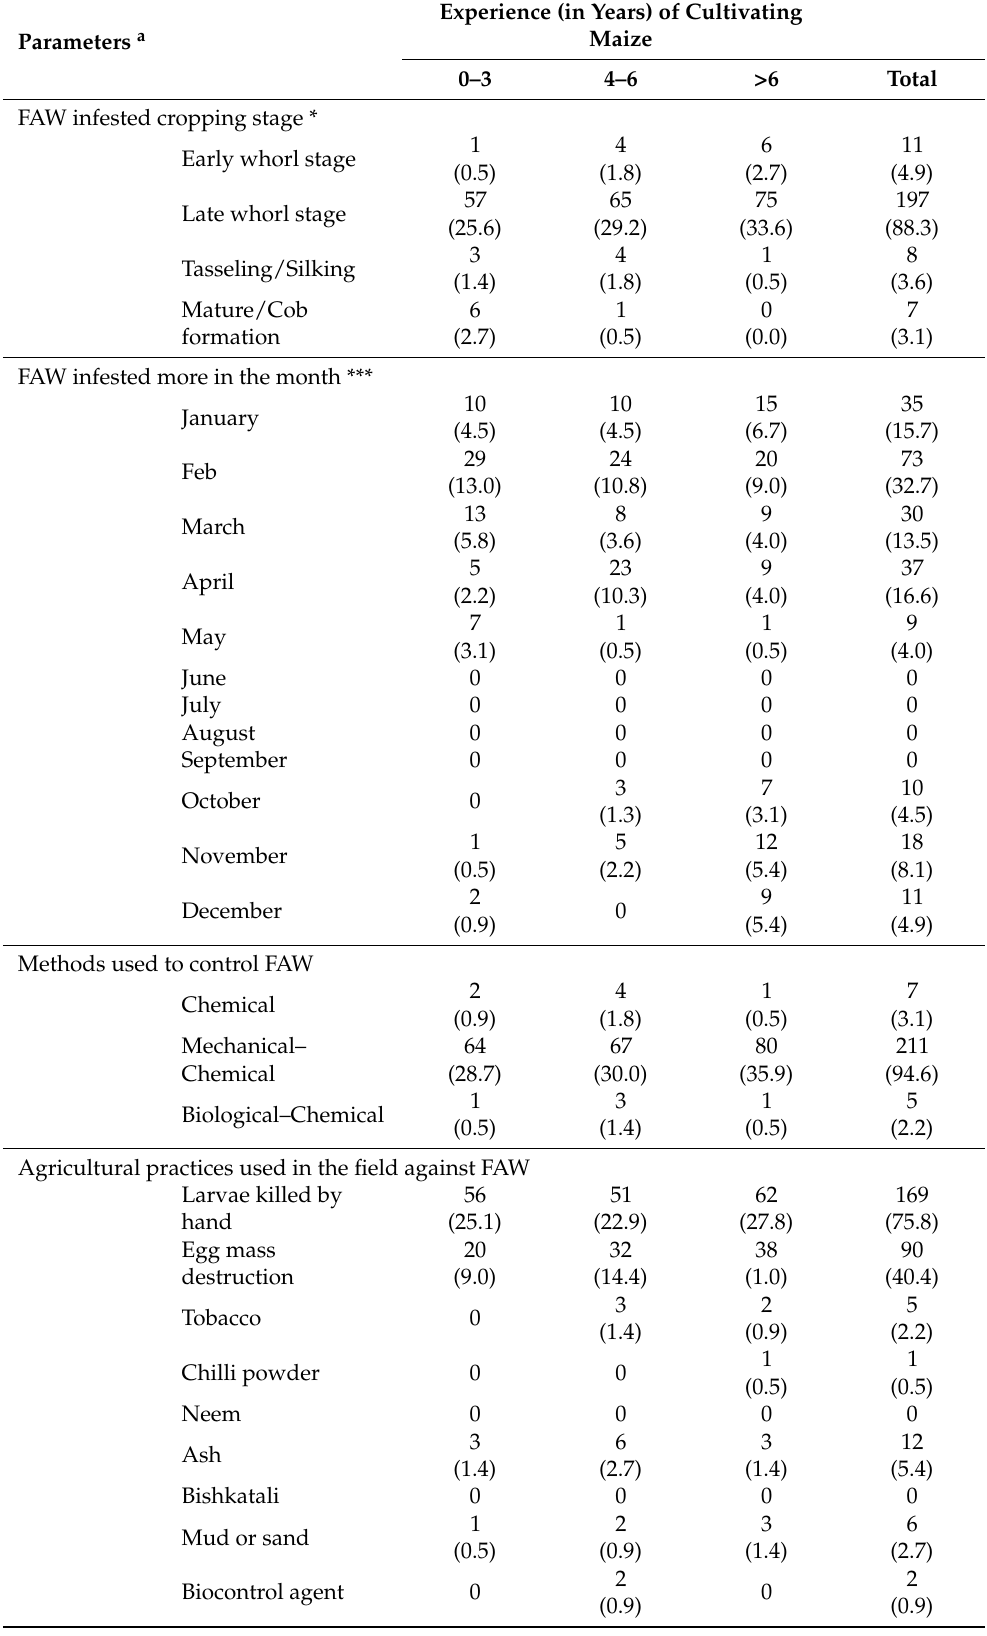
Table 3. Perceptions of maize farmers of fall armyworm infestations and management.